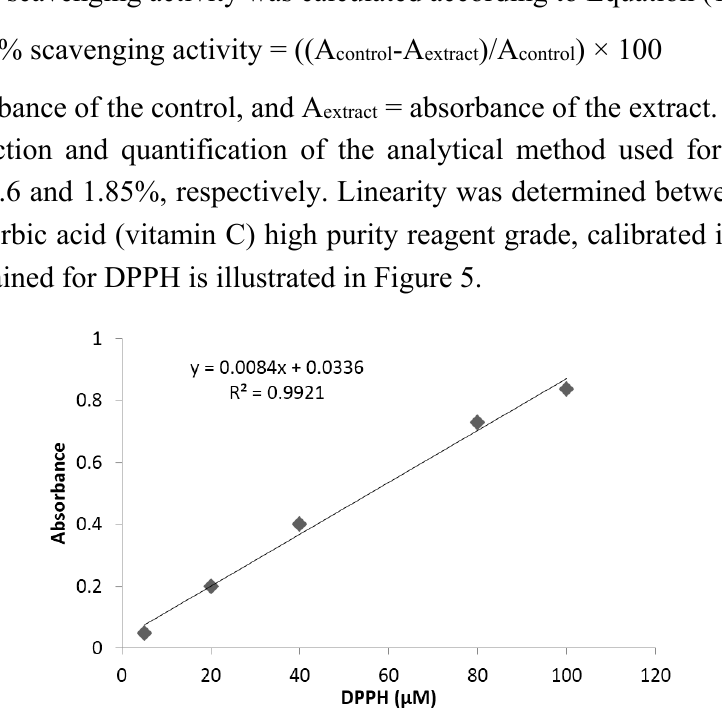
Figure 5. Representative standard curve obtained for antioxidant